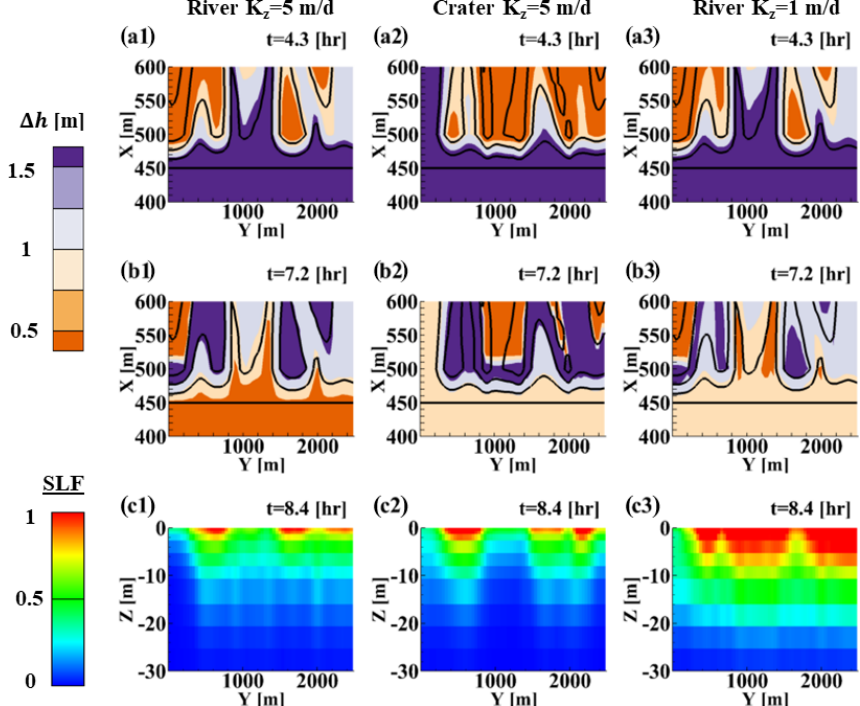
Figure 5. Top row (a1–a3) maps of the maximum near-surface head differences between those at the peak of the flooding and the initial, pre-surge values (denoted (cid:49)h 1 ) as a function of the cross-shore X and alongshore Y coordinates. Middle (b1–b3) maps of the maximum subsurface head differences between those near the end of the surge ( t = 7 . 2h, Fig. 2) and the initial, pre-surge heads (denoted (cid:49)h 2 ) as a function of X and Y . Bottom (c1–c3) quicksand potential SLF at the shoreline, X = 450m, as a function of the vertical Z and alongshore Y coordinates. These three metrics are plotted for the River topography with K z = 5md − 1 (left, a1–a3 ), Crater topography with K z = 5md − 1 (center, a2–c2 ), and River topography with K z = 1md − 1 (right, a3–c3 ). In the upper and middle panels (map views a1–a3 and b1–b3 ) the black contours are surface elevations with 1m intervals. The horizontal line at X = 450 is the coastline ( Z = 0). The lower panels are plotted for t = 8 . 4h, the time at which the vertical gradients peaked in all simulations all along the